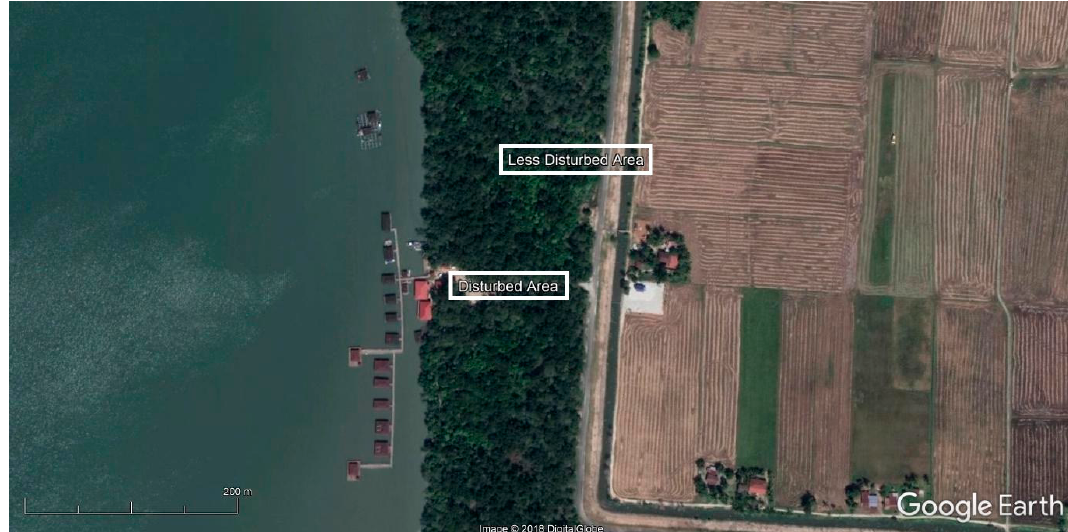
Figure 1. Segantang Garam, Merbok, Kedah mangrove forest.